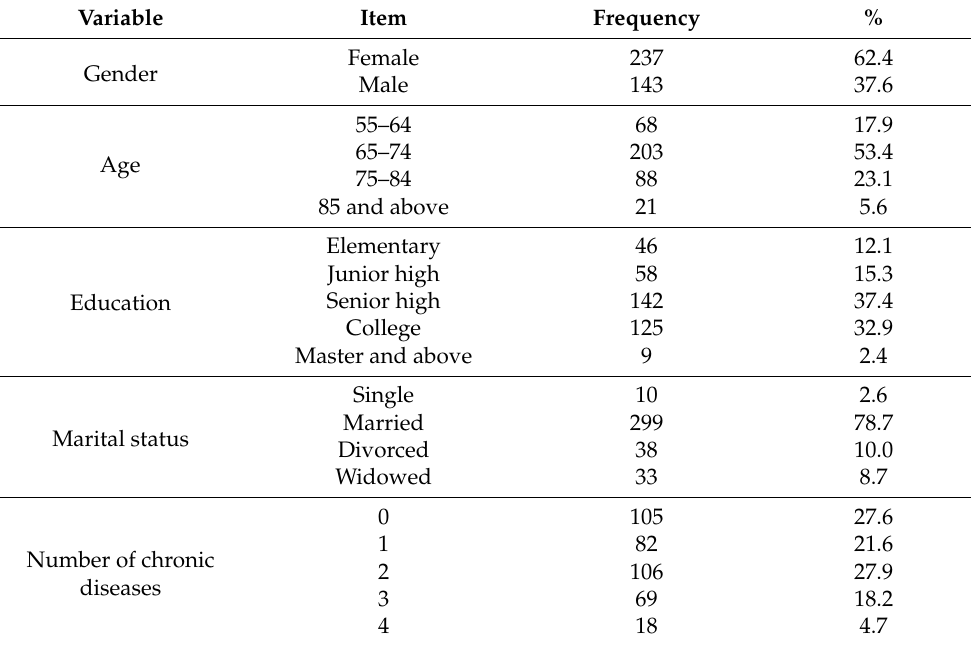
Table 3. Descriptive statistics of individual-level subjects’